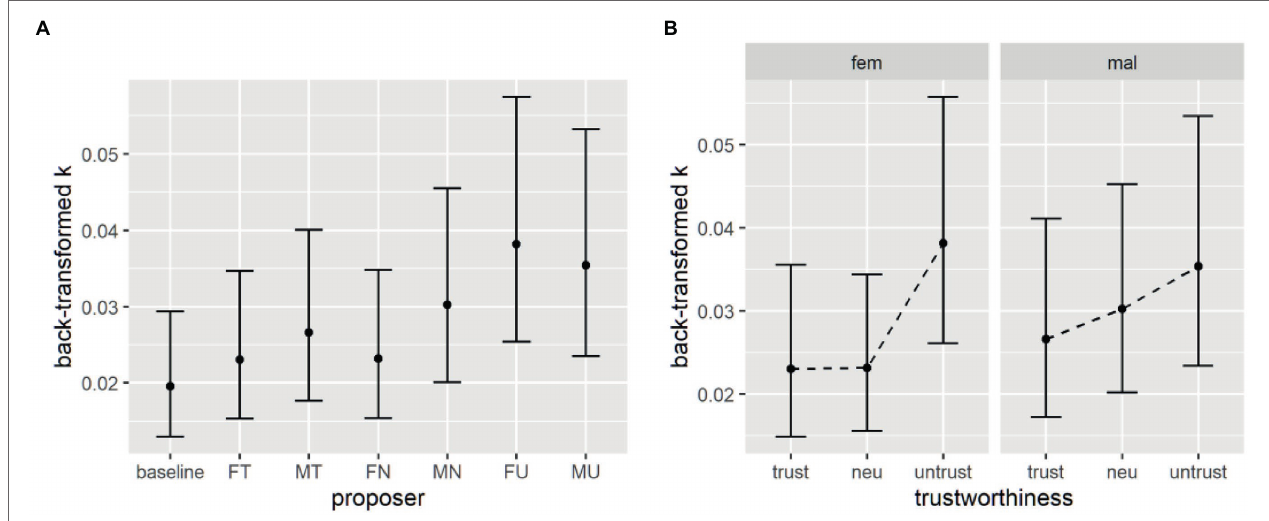
FIGURE 3 | Discounting parameters back-transformed from the log space. (A) Parameter estimates from the first model. ( B) Parameter estimates from the second model without the